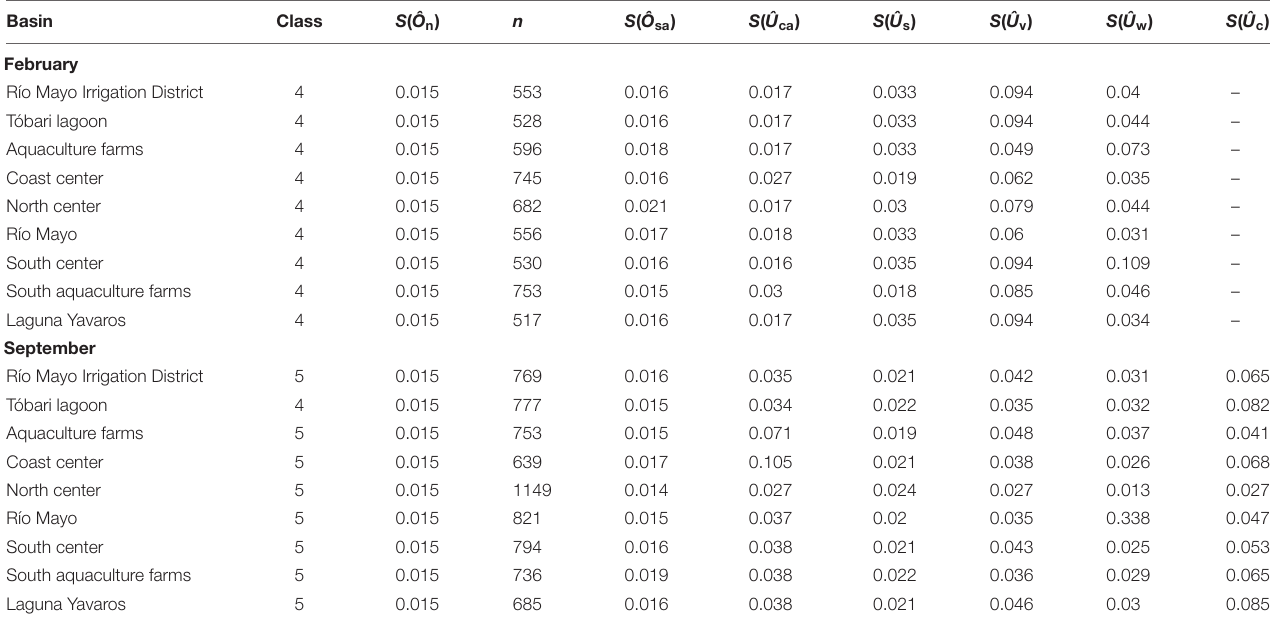
TABLE 1 | Number of classes by sub-basin, sampling number ( n ), standard error of the estimated overall accuracy S ( Ô n ), selected accuracy S ( Ô sa ) of the allocation that was chosen, and estimated user’s accuracy for each class S ˆ U i . Basin